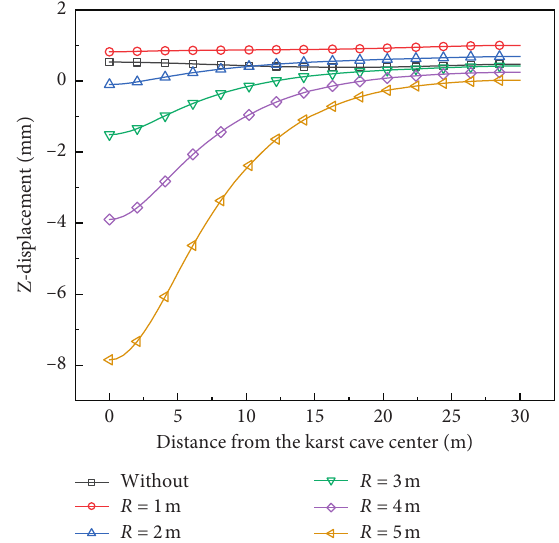
Figure 8: Z -displacement curves of the tunnel vault with varying sizes of the karst cave.